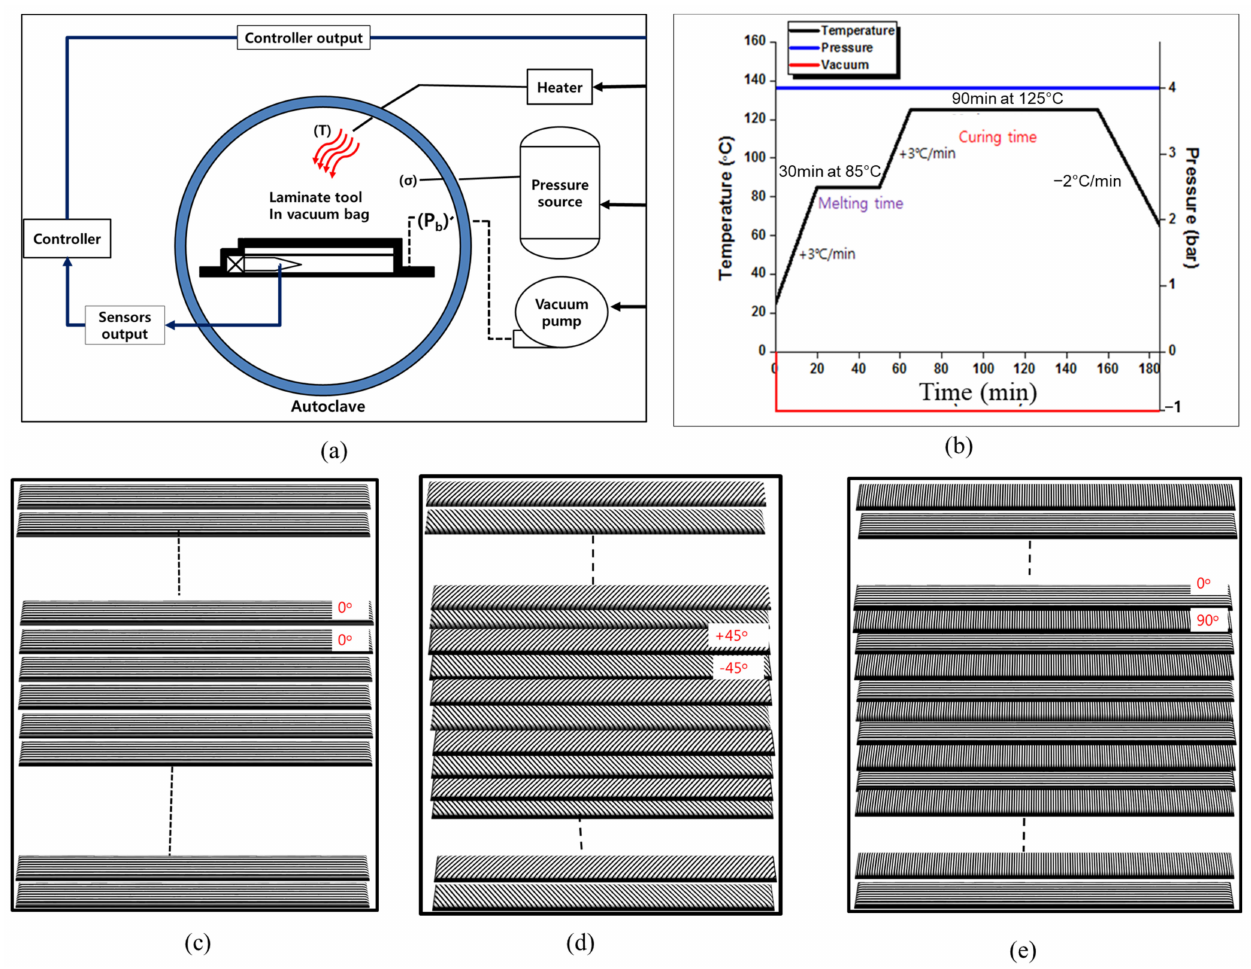
Figure 1. Molding process; ( a ) Flow diagram of autoclave molding method; ( b ) Cycle of molding and curing conditions, ( c – e ) Stacking sequence diagram of [0 ◦ ] 36 , [0 ◦ /90 ◦ ] 18 , [+45 ◦ / − 45 ◦ ] 18 , respectively. Table 1. Physical properties of UIN200C